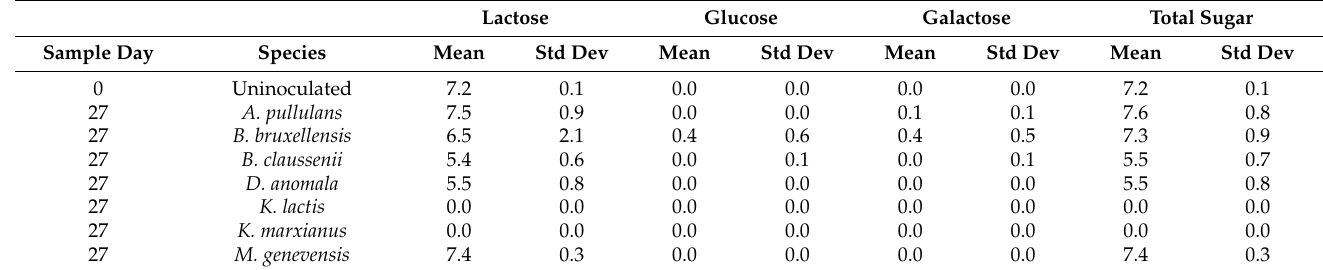
Table 2. Sugar concentrations under aerobic fermentation (g/100 g).